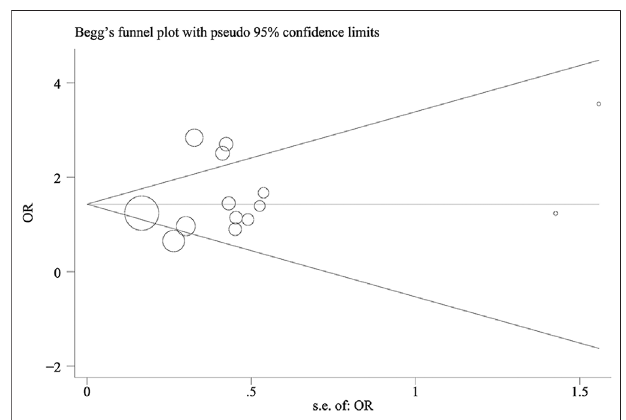
FIGURE 4 | Begg ’ s funnel plot of TNF- α -308 polymorphism and COPD risk (Asian population for GA vs.